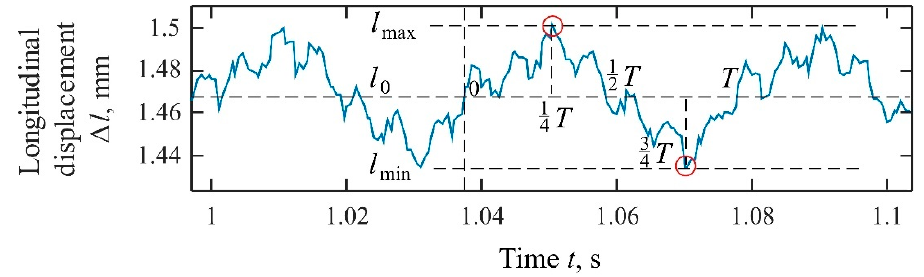
Figure 3. Longitudinal deformation of a sample in dynamic loading: F st = 700 N, A = 250 N, ω = 25 Hz.